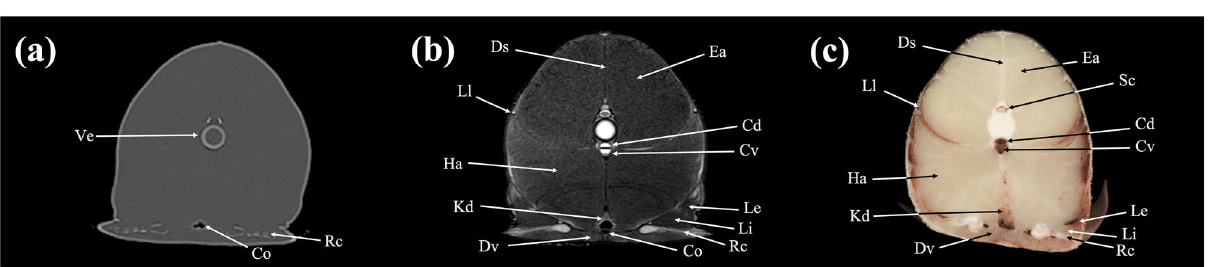
Figure 12. Transverse ( a ) CT, ( b ) MR, and ( c ) cryosection images of a banded houndshark ( Triakis scyllium ) at level 12 of Fig. 25. Cd Caudal artery, Co cloaca, Cv Caudal vein, Ds Dorsal skeletogenous septum, Dv Depressor